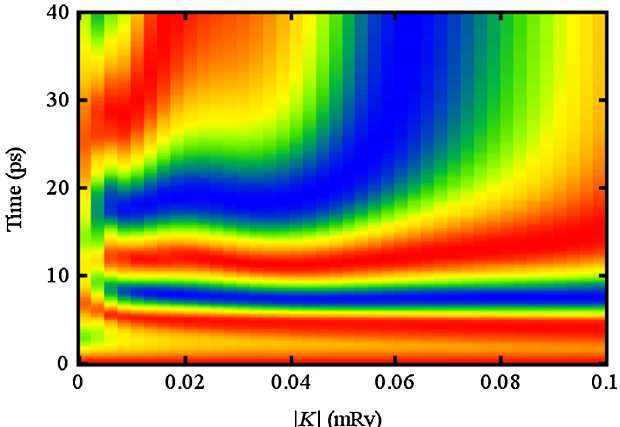
FIG. 6. Switching times as a function of out-of-plane anisot- ropy. The duration of the magnetic pulse is 5 ps, the z component of the applied magnetic field is 5 T, and the x component is 3 T. (All other parameters are the same as Fig.